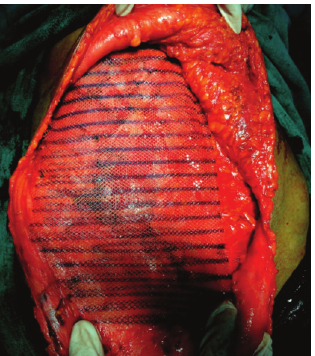
Figure 7: Cut section of the